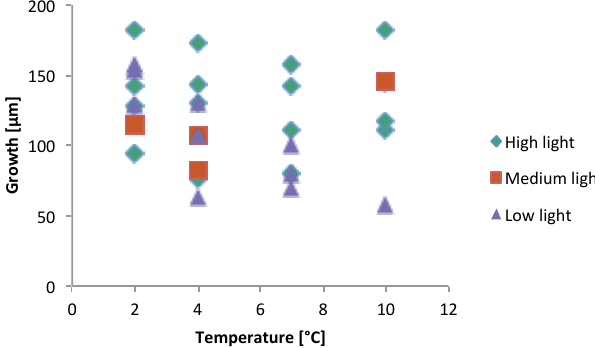
Figure 11. Total perithallial growth during experiment of samples harvested at end of experiment; multiple transects from individuals were